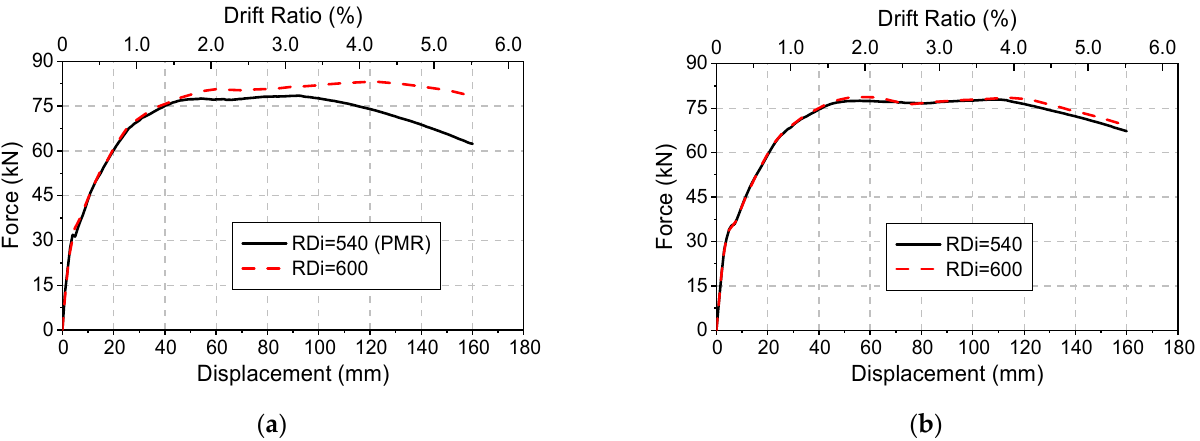
Figure 26. Force–displacement relation of different recess diameters: ( a ) shallow recess (RDe = 50 mm, CT = 20 mm); ( b ) deep recess (RDe = 100 mm, CT = 20 mm). Larger recess diameter means longer horizontal distance between nodes and higher relative displacement under the same shear angle, and joint deformation with different RDi values are shown in Figure 27. Joint deformation of the models with shallower recess is more sensitive to RDi variation. For deeper recess, gap distance changes little with RDi increase, while lifting displacement of the model with larger RDi is higher than that with smaller RDi due to geometry change.